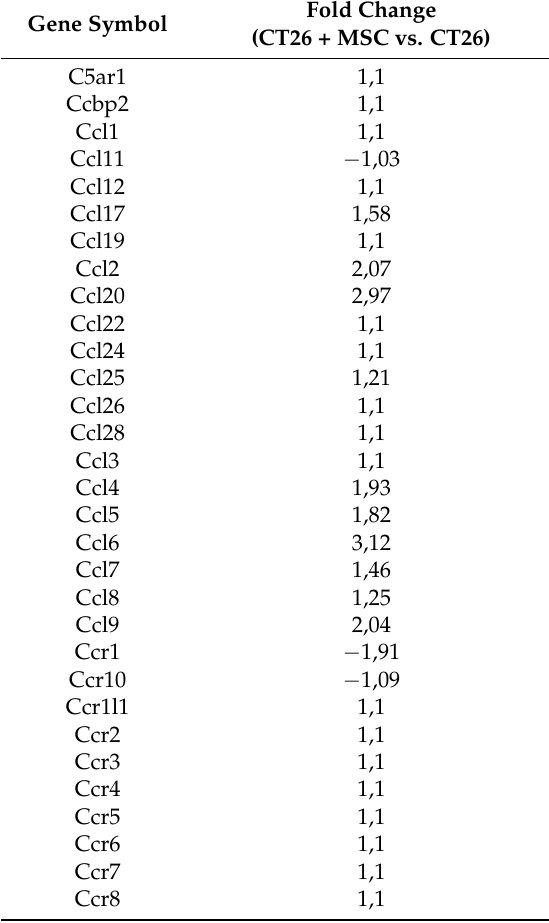
Table 2. Regulation of chemokines and chemokine receptors using a PCR array on cocultured CT26 and